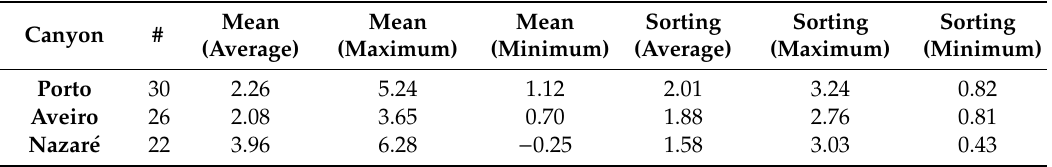
Table 2. Average values, maximum, and minimum of mean and sorting. Values in φ units for the three canyon head areas (# = number of